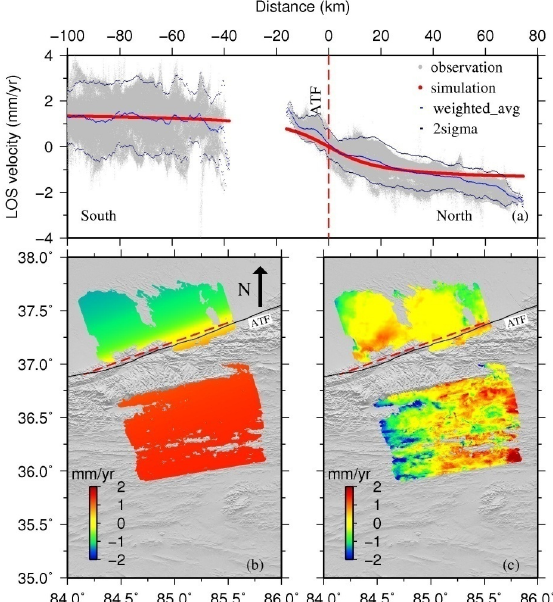
Figure 9. ( a ) A298 mean LOS velocity profiles (red dots) and the weighted average profile (dark blue) with 2 σ deviation (light blue). All the points shown in the left are projected onto the profile as red dots. The red line is the best-fit model with a slip rate of 8.0 mm/year and 14.5 km locking depth; ( b ) Model simulation map from the best-fit model values. The fat black arrow shows the north direction; ( c ) Residuals between model and observation (Figure 5b) results.